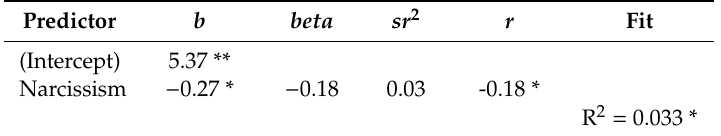
Table 4. Regression results for narcissism using servant leadership as